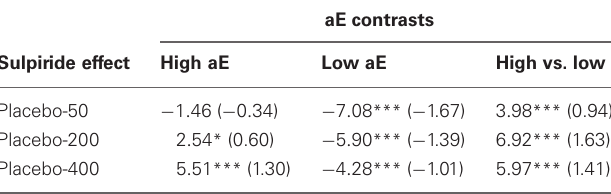
Table 2 | Substance effects within and between high and low aE in posterior vs. anterior theta reactivity: t -values of contrasts (effect size d ).